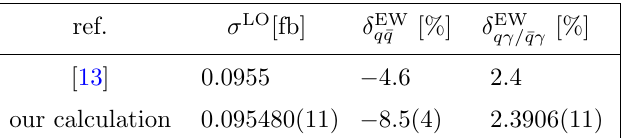
, (cid:14) EW of q (cid:22) q q(cid:13)= (cid:22) q(cid:13)